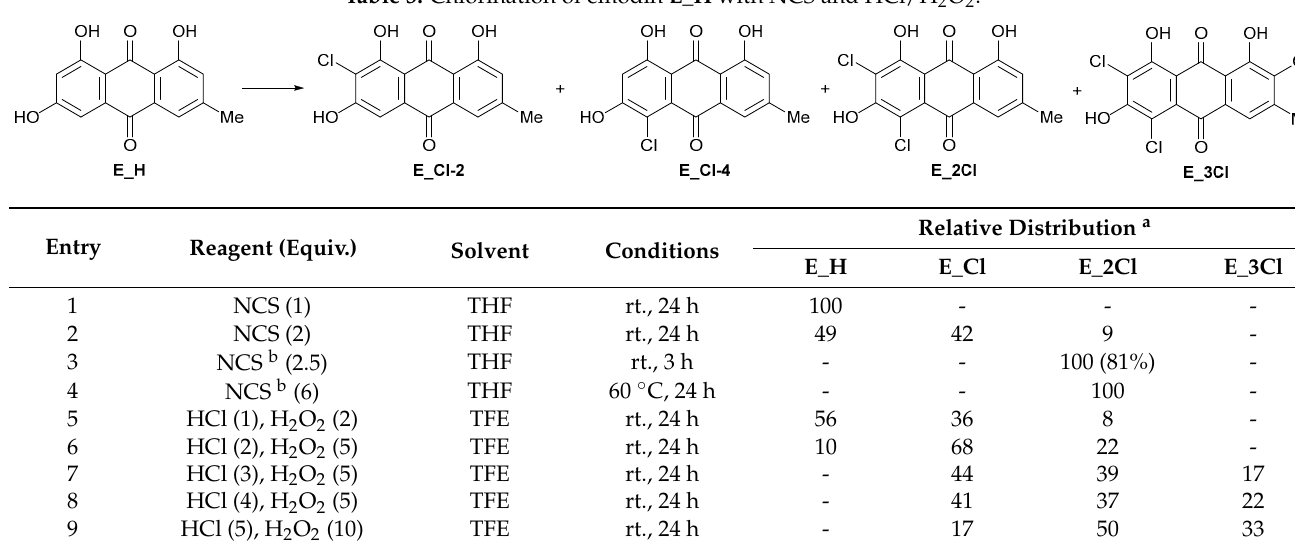
Molecules 2021 , 26 , x FOR PEER REVIEW 6 of 17